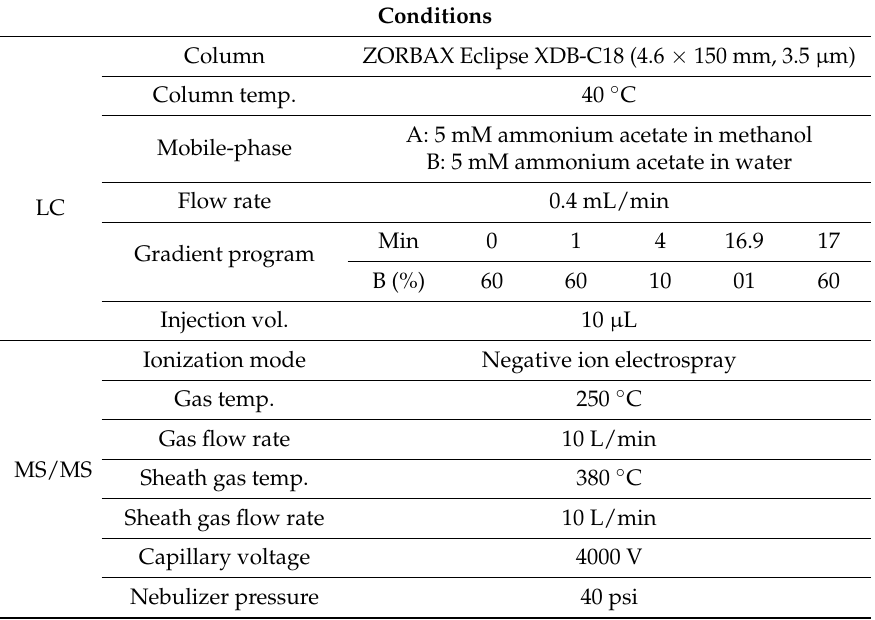
Table 2. The laboratory analysis of the artificial sweeteners and the triclosan (negative